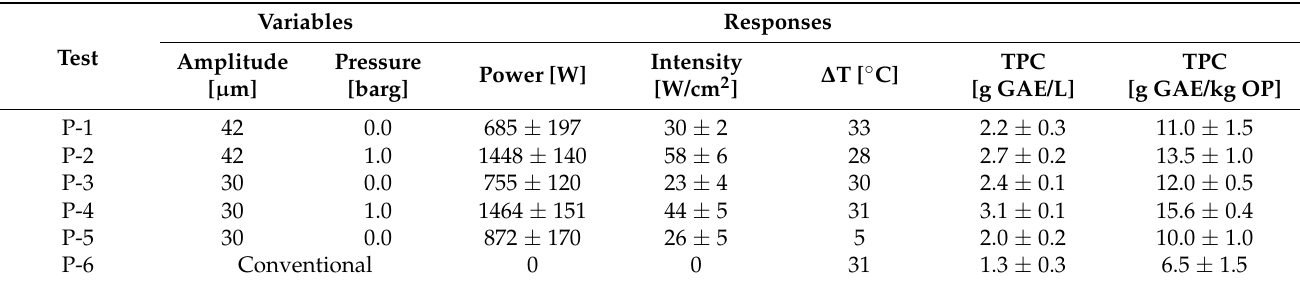
Table 4. Process parameters and responses observed at Pilot-scale